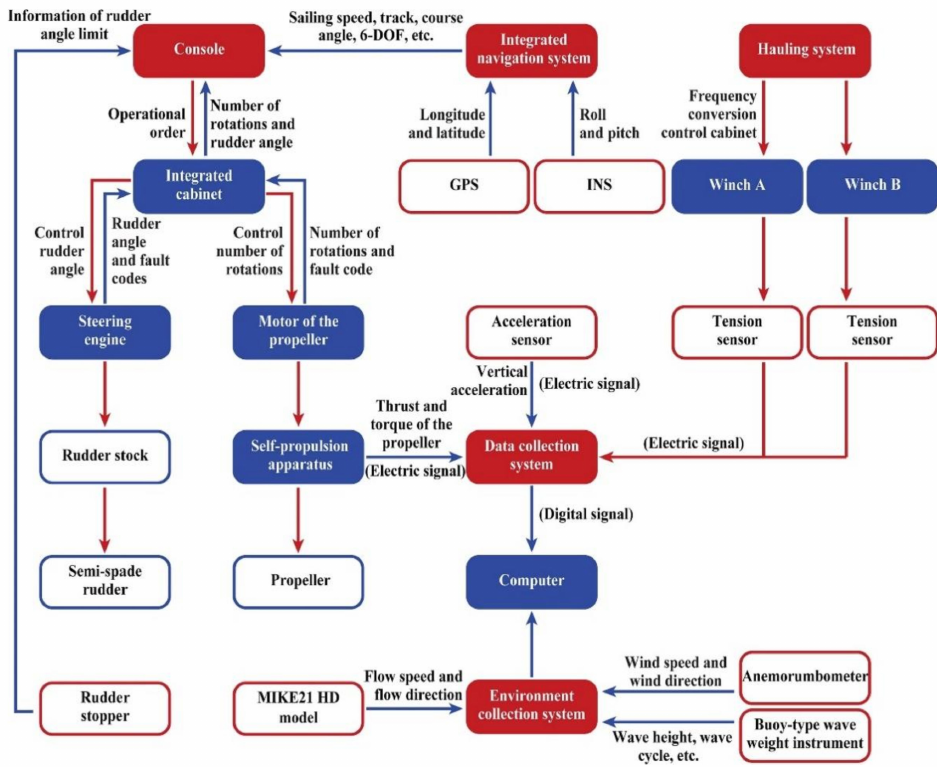
Figure 9. Block diagram of two test systems in actual seas [80].